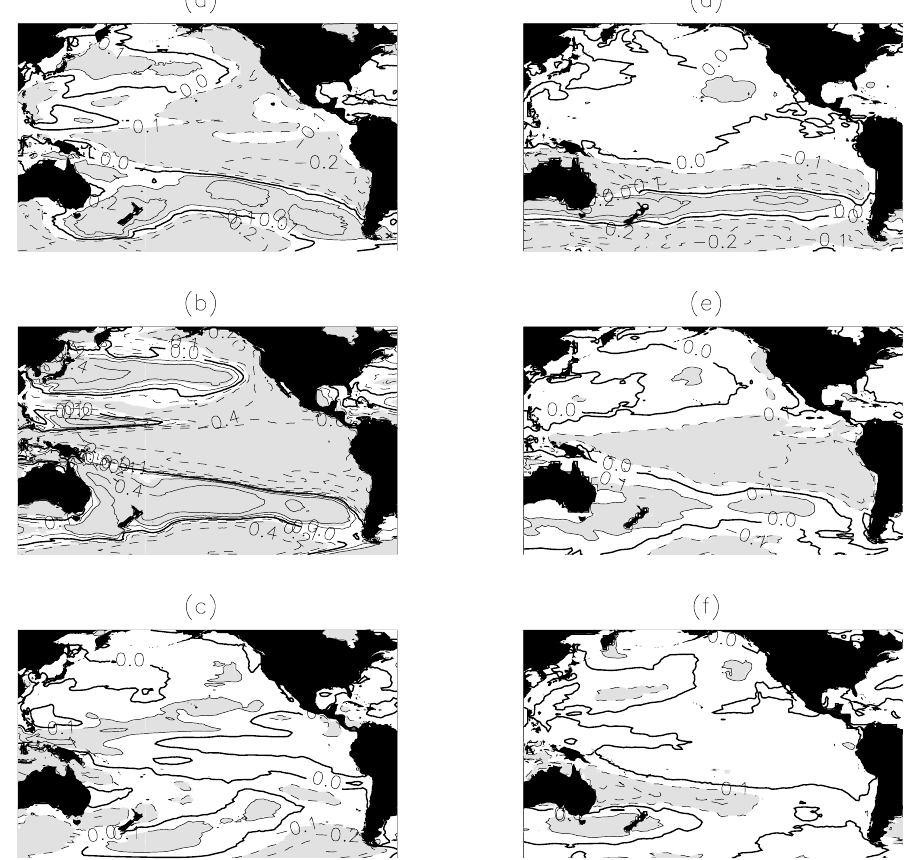
Fig. 14. Correlation of the monthly mean global SSTs with the time series of the three leading EOFs in FGOALS, (a) for SAM, (b) for SPD and (c) for W, and MIROC (d) for SAM, (e) for SPD and (f) for W. Correlation contour intervals are 0.1 with the zero correlation line given as the thick, solid black line and positive (negative) correlations denoted by the solid (dashed) lines. Statistically significant correlations ( p ≤ 0.05) are shaded in